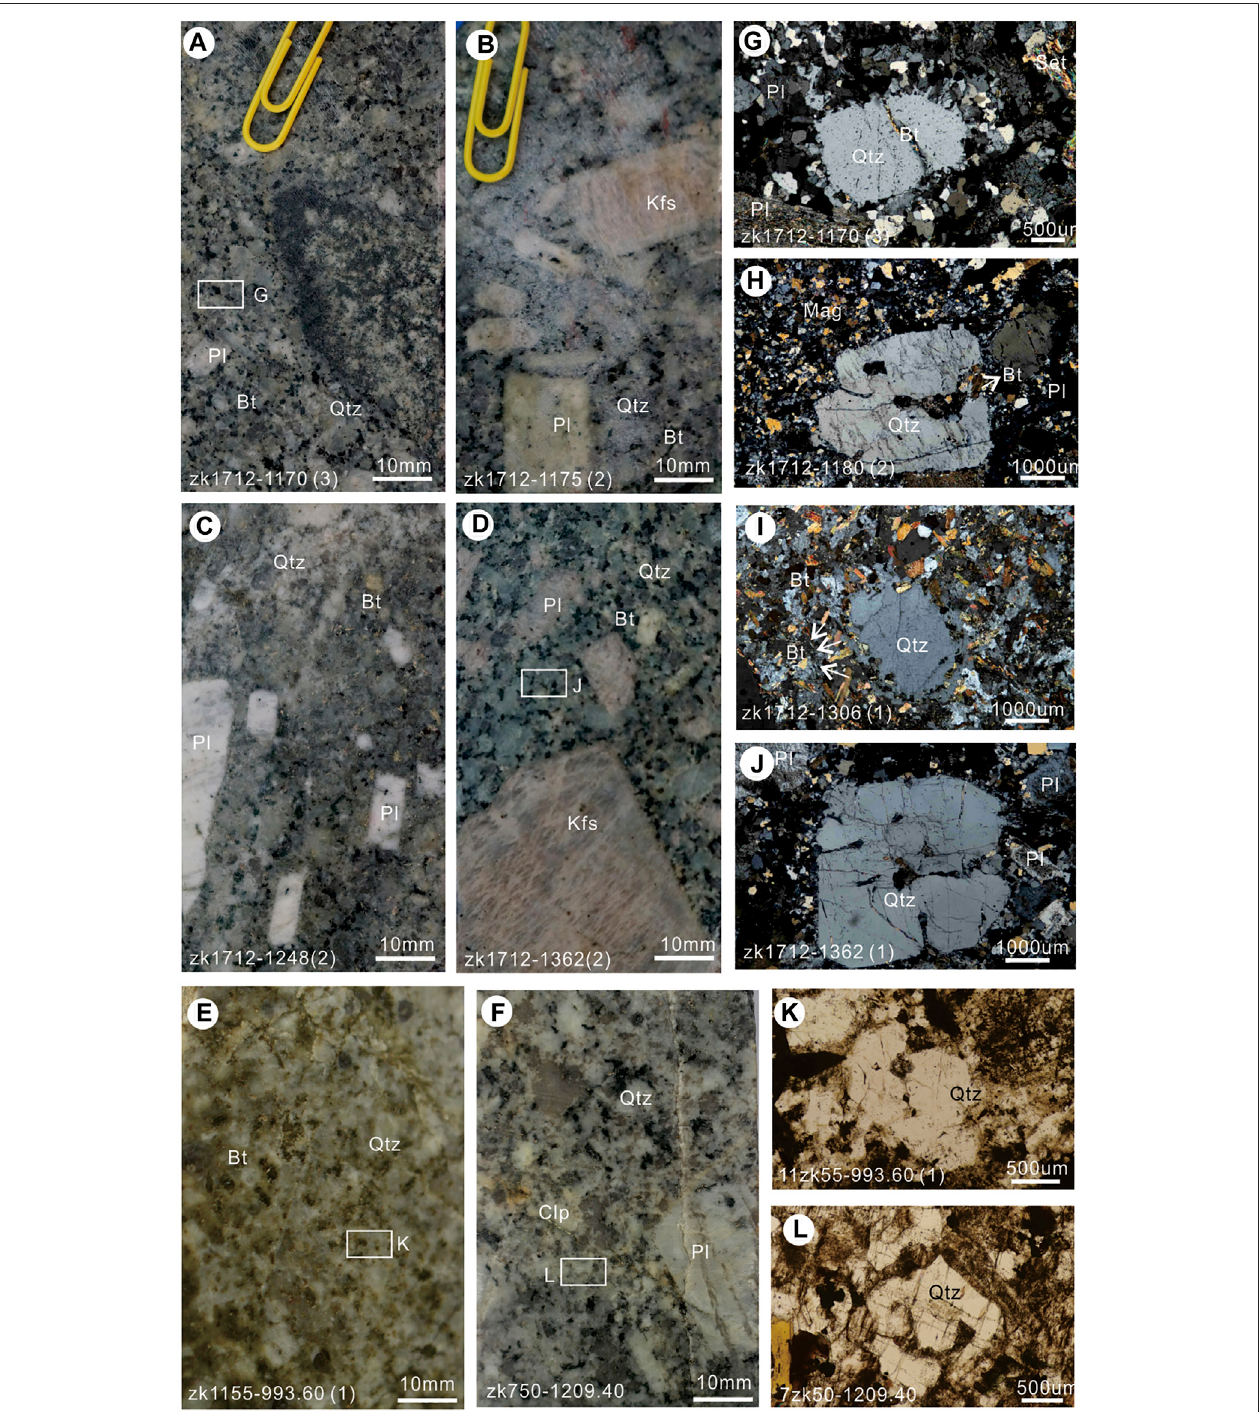
FIGURE2| PhotomicrographsofrepresentativemineralassemblagesfromtheHongniu – HongshanCudeposit.Thequartzformsphenocrystandisinthematrixin the porphyritic granite at the Hongniu – Hongshan deposit Panels (2A – F) . Quartz coexists with K-feldspar, plagioclase, amphibole, and biotite. Quartz phenocryst is subhedral – euhedraland 4 – 6 mm in diameter, and some ofthem show rounded or embay surfaces (Panels 2G – L ).The quartz matrix isallotriomorphic and 0.5 – 1 mm in size. Amp = amphibole; Bt = biotite; Kfs = K-feldspar; Pl = plagioclase; Qtz = quartz (after Kretz, 1983).